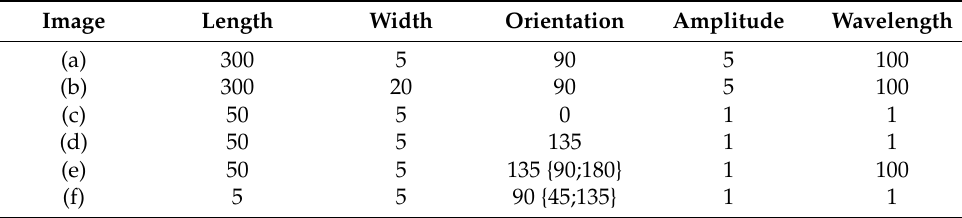
Table 1. Parameters set in TiGenerator [28] to create the TIs used in the example. For constant properties, the table shows the ‘Mean’ parameter. For random properties with triangular distribution, the table shows the ‘Mean ({min;max})’